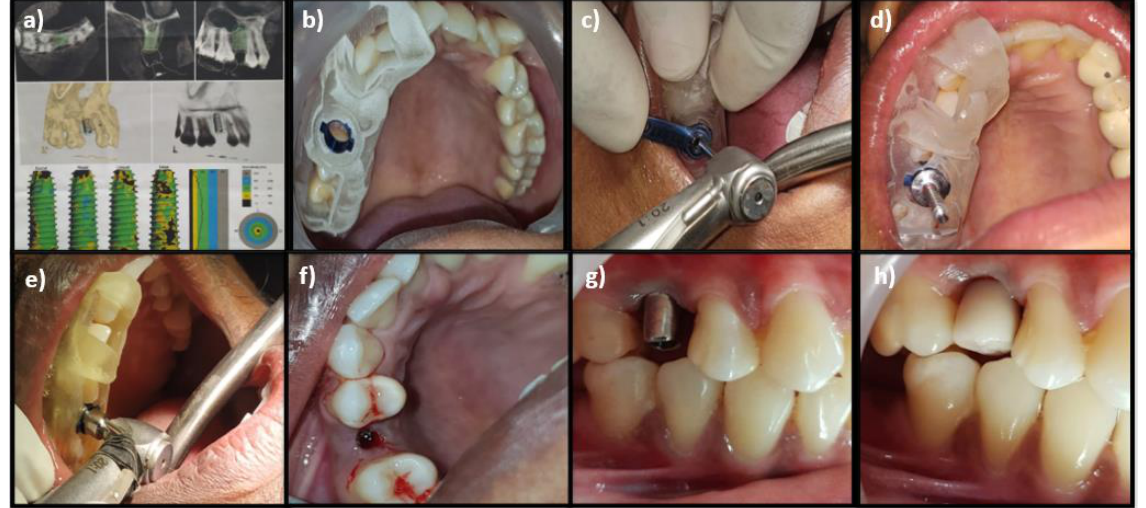
Figure 2. ( a ) Superimposition of CBCT for surgical guide preparation; ( b ) Stabilization of the surgical guide; ( c ) Osteotomy site preparation through the surgical guide using an initial pilot drill; ( d ) Subsequent osteotomies in the sequence of the drilling protocol; ( e ) Implant insertion; ( f ) Implant equi-crestally placed; ( g ) Abutment placed; ( h ) Provisional restoration.